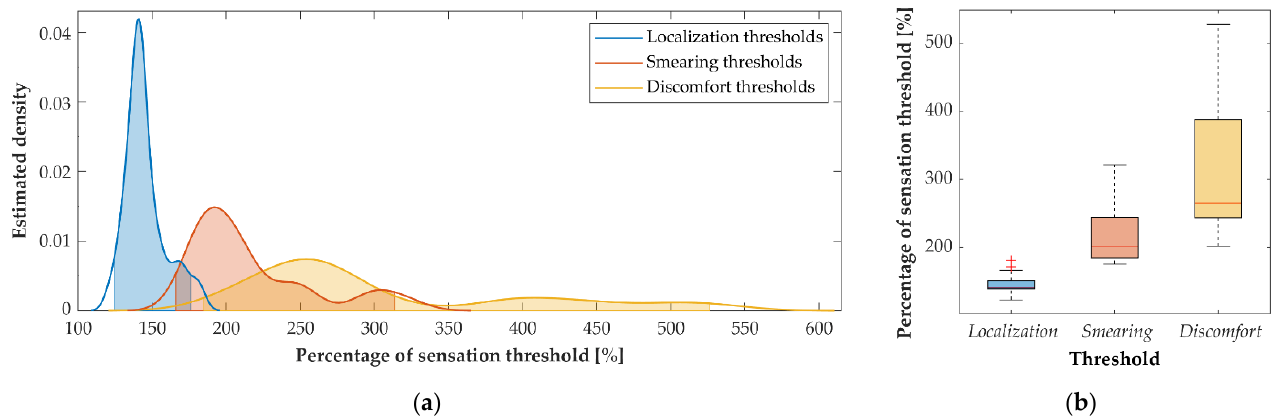
Figure 3. The localization (LT), smearing (SMT) and discomfort (DT) threshold as the function of sensation threshold: ( a ) The estimated probability density functions. Shaded parts of the estimated density curves are confidence intervals (95% of the data); ( b ) Boxplot representation of the threshold distribution. The red line, box, whiskers and red mark indicate the median, interquartile range upper/lower boundaries and outlier, respectively.